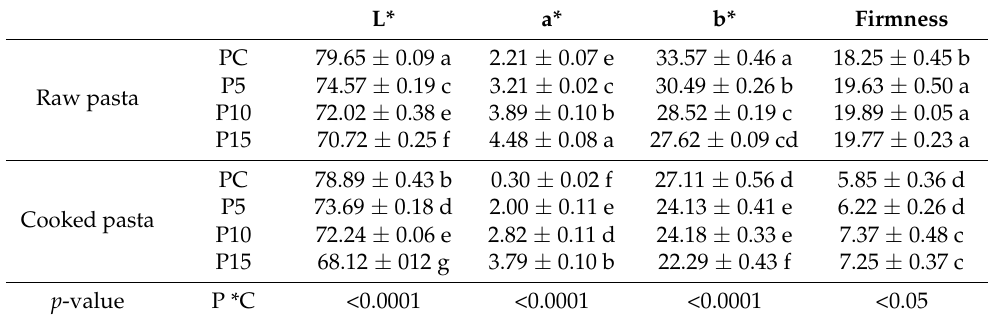
Table 2. Color and firmness of fresh